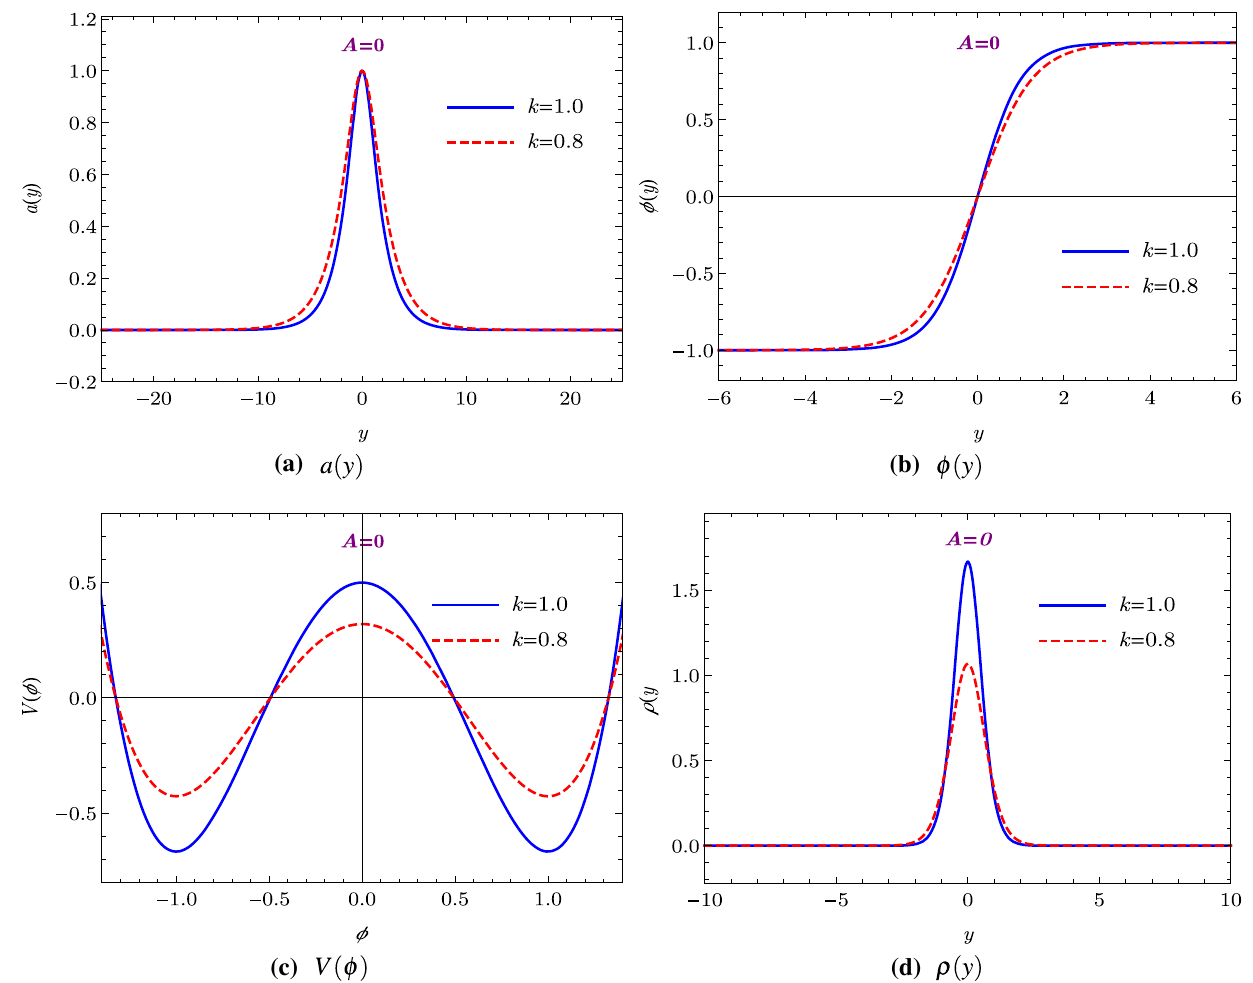
Fig. 2 The profiles of the warp factor a ( y ) , scalar field φ( y ) , scalar potential V (φ) , and energy density ρ( y ) for the case of A =